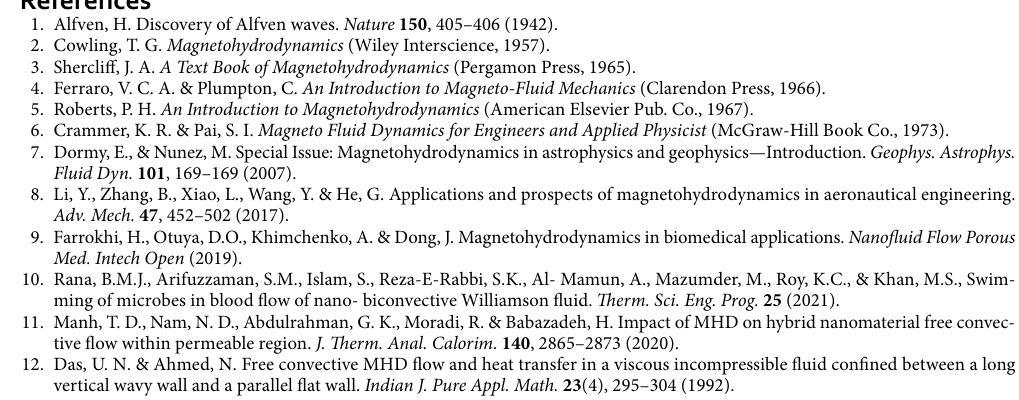
Table 3. Comparison of computational values of Sherwood number for various K, Sc and t obtained by Asogwa et.al 50 , Seth et. Al 51 , Kataria and Patel 52 and present authors.